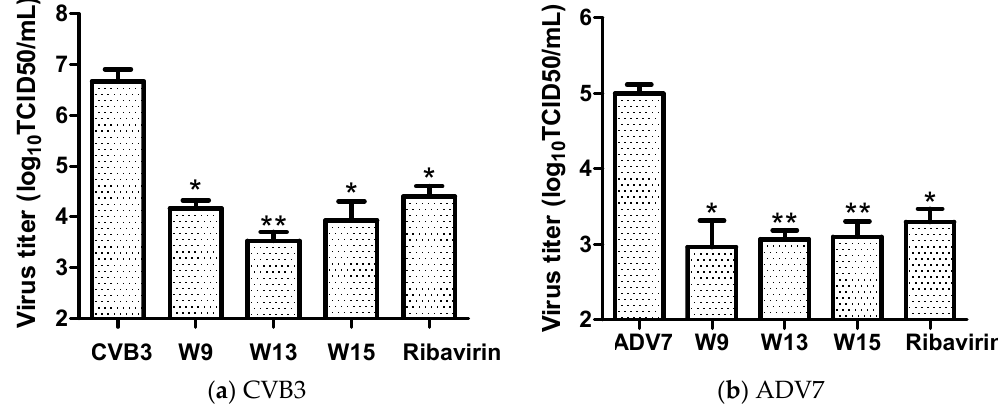
Figure 2. The effects of W9, W13, and W15 on progeny virus production. Hep-2 cells infected with 100 TCID 50 of CVB3( a ), or HeLa cells infected with 100 TCID 50 of ADV7( b ), were incubated in the absence (virus control) or presence of 120 μ M W-9, 160 μ M W-13, 160 μ M W-15, or 160 μ M ribavirin for 36 h, and the culture media and cell lysates then harvested for virus titration. Viral titers are presented as Log 10 TCID 50 /mL. * p < 0.05; ** p < 0.01, compared with the virus control group.